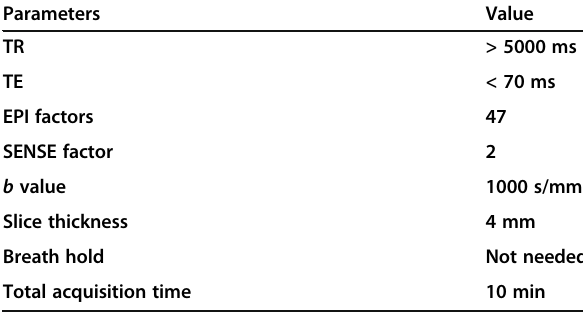
black and white inverse gray